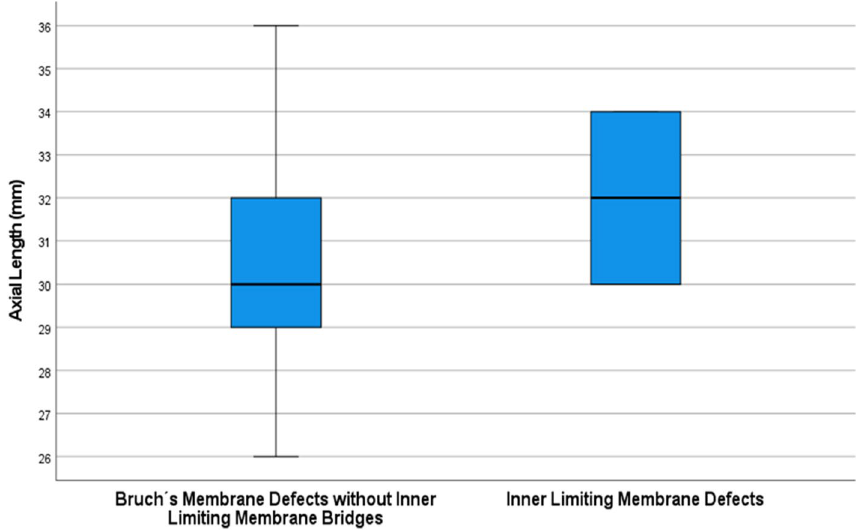
Figure 6. Boxplot showing the distribution of axial length stratified by the presence of inner limiting membrane (ILM) bridges (with Bruch’s membrane defects) versus the presence of Bruch’s membrane defects without